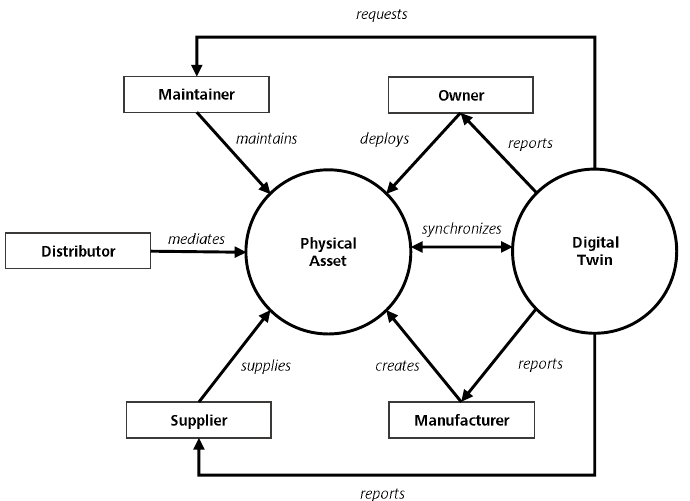
Figure 2. Cybersecurity knowledge